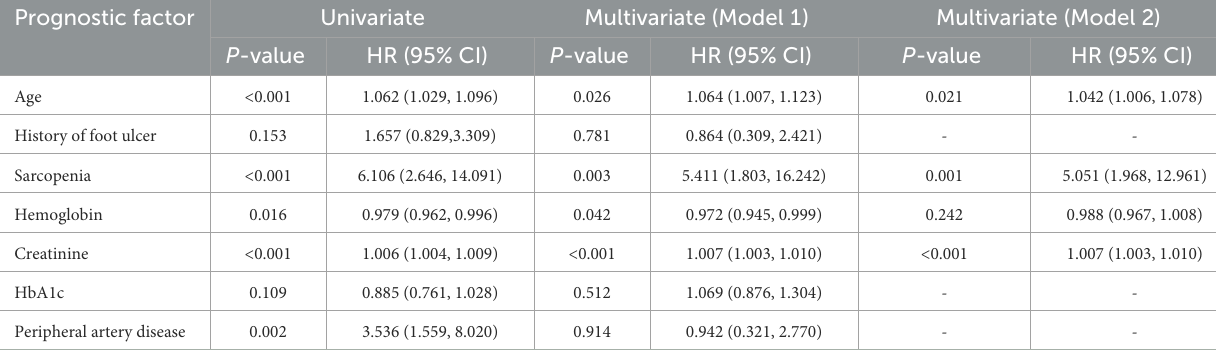
TABLE 3 Prognostic factors for all-cause mortality rate in patients with DFUs (univariate and multivariate analyses). Prognostic factor Univariate Multivariate (Model 1) Multivariate (Model 2)